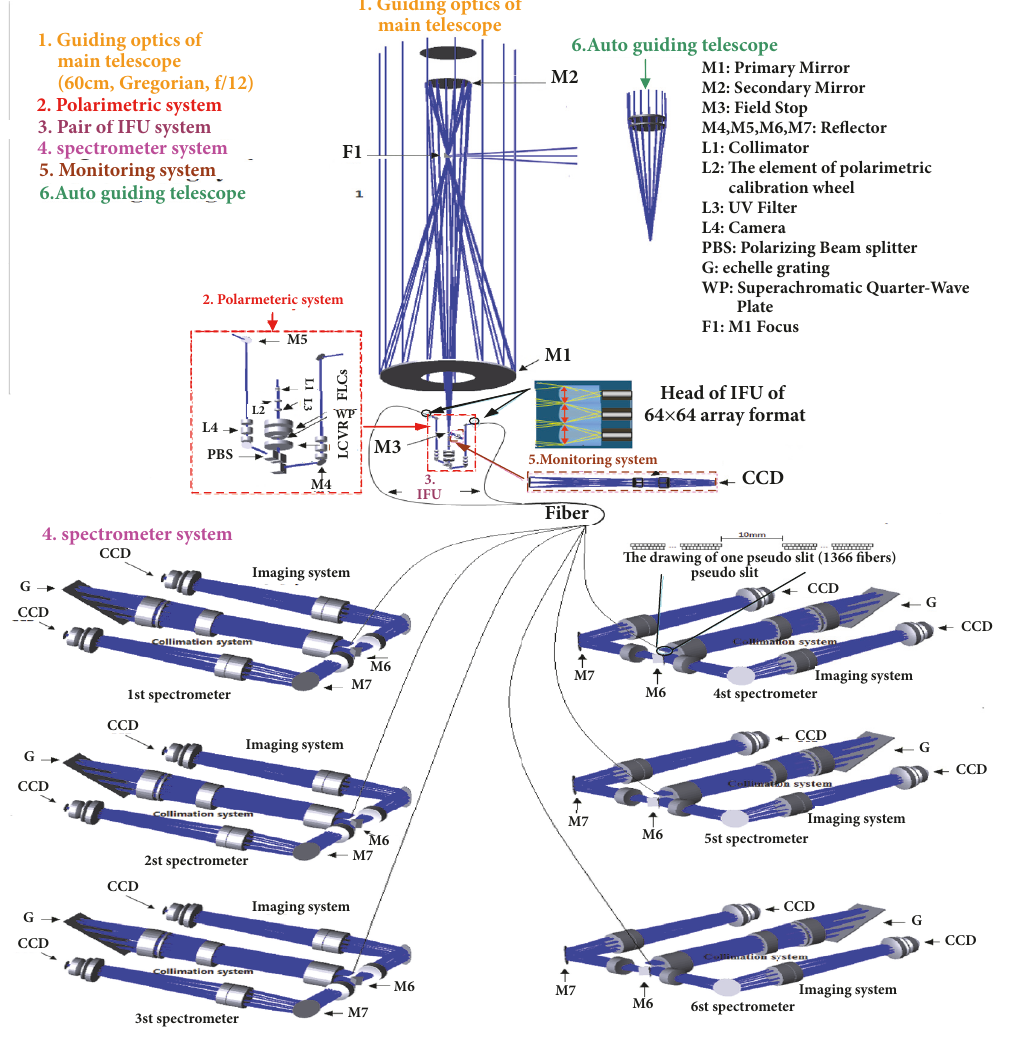
Figure 1: The optical path of